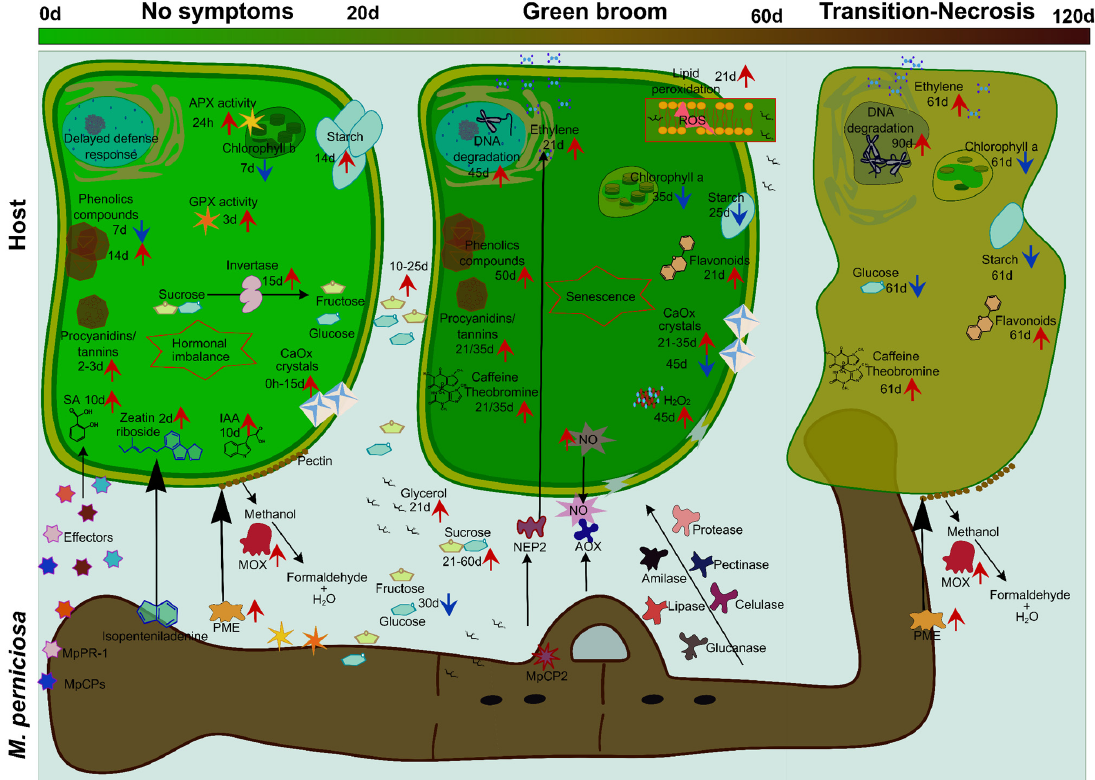
Figure 5. Molecular processes triggered in the M. perniciosa x host pathosystem in the development of witches’ broom disease in compatible interaction. The three stages of witches’ broom disease are presented: no symptoms, green broom, and necrosis. Red up arrows represent increase and blue down arrows a decrease of reported substances at the stage or time indicated in days (d) or hours (h). APX: Ascorbate peroxidase; GPX: Glutathione peroxidase; MpPR: Pathogenesis-related protein